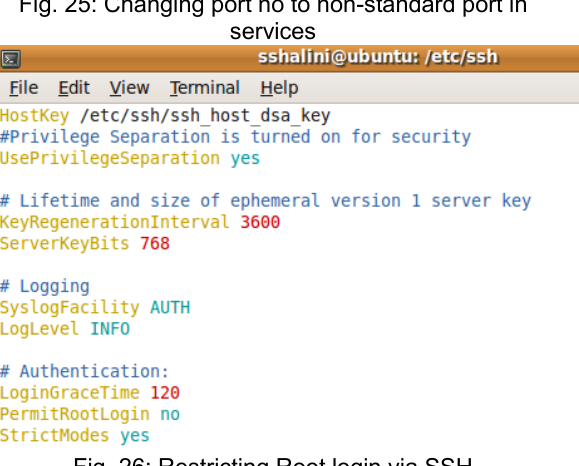
Fig. 26: Restricting Root login via SSH